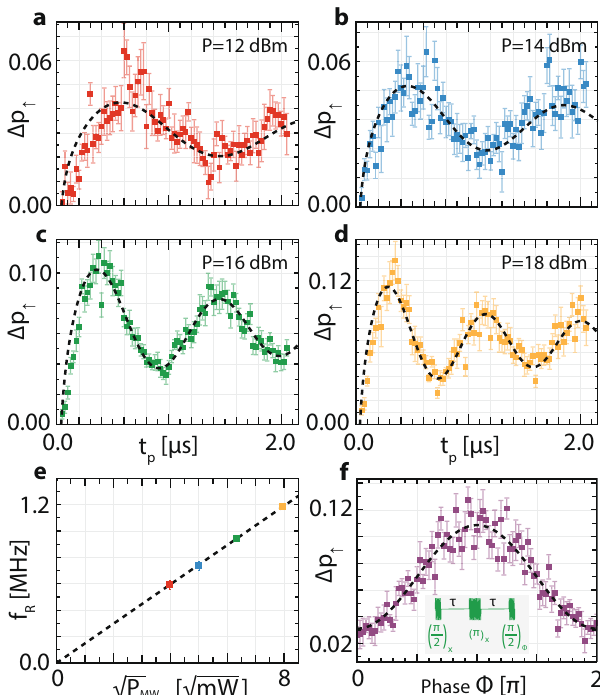
Fig. 3 Coherent spin control of the molecular electronic state. a – d Spin-up difference signals Δ p ↑ for four different mircowave power values as a function of pulse duration, showing clear Rabi oscillations. We note that Δ p ↑ does not reach 1 since the echo sequences are performed by driving a single frequency tone while the fl uctuating Overhauser fi eld in natural silicon detunes the instantaneous resonace from the driven frequency as has been observed previously 20 . Error bars indicate ±1 σ , and black dashed lines indicate fi ts to a power-law decay. For the highest driving strength in d we obtain a Rabi frequency of f R = 1.18 MHz. e The extracted Rabi p ffiffiffiffiffiffiffiffiffiffi P frequencies as a function of microwave amplitude B 1 (cid:4) show a MW linear dependence. f Phase control, demonstrated by a spin echo sequence in which the initial and fi nal π rotations differ in phase by ϕ , producing a 2 sinusoidal variation on the recovered spin state. Experimental parameters are P MW = 14 dBm, t π = 840 ns and τ = 50 ns, and the pulse sequence is indicated in the